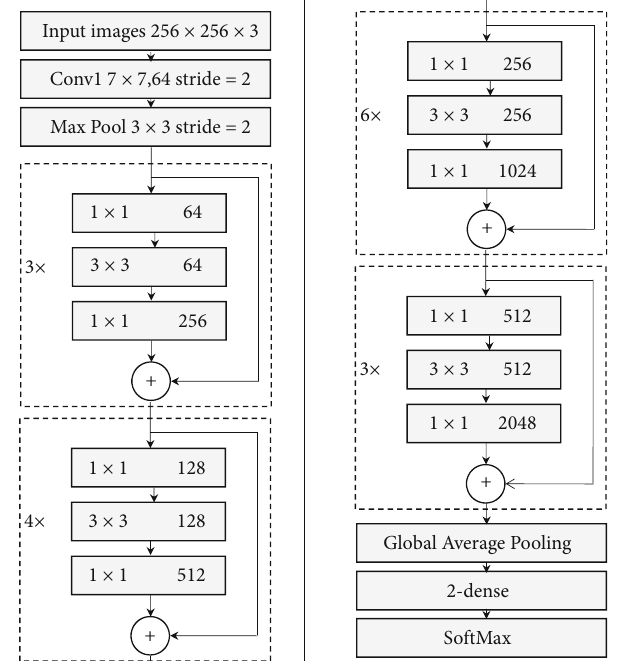
Figure 2: The architecture of the proposed CNN which is modi fi ed based on the classic ResNet50. Two major changes are as followed. First, the size of the input layer is modi fi ed from 224 × 224 × 3 to 256 × 256 × 3 . Second, a fully connected layer with 2 units is added before the Softmax